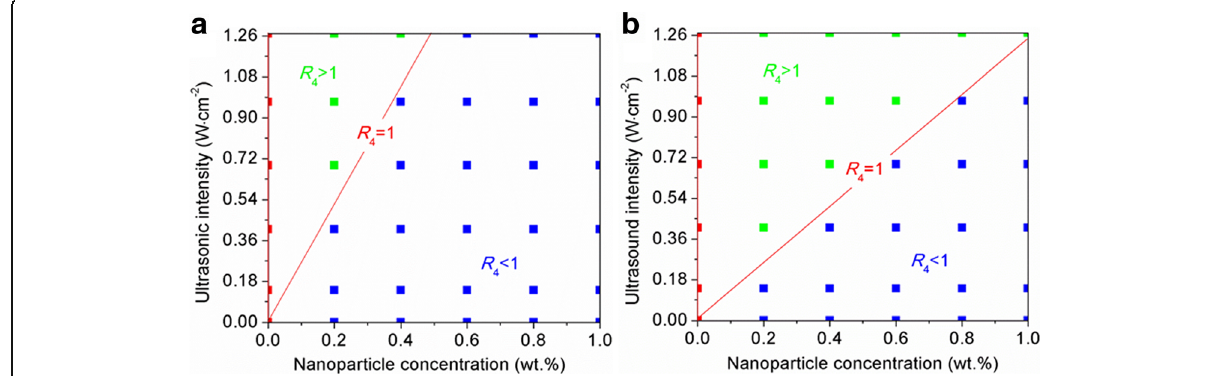
Fig. 6 A diagram showing the different effects of ultrasound and nanoparticles on the supercooling degree of water [ a Al 2 O 3 nanoparticles, b SiO 2 nanoparticles]. The blue, red, and green dots represent that the required supercooling degree for the water solidification with nanoparticles and ultrasound is lower than, equal to, and higher than that with ultrasound individually,